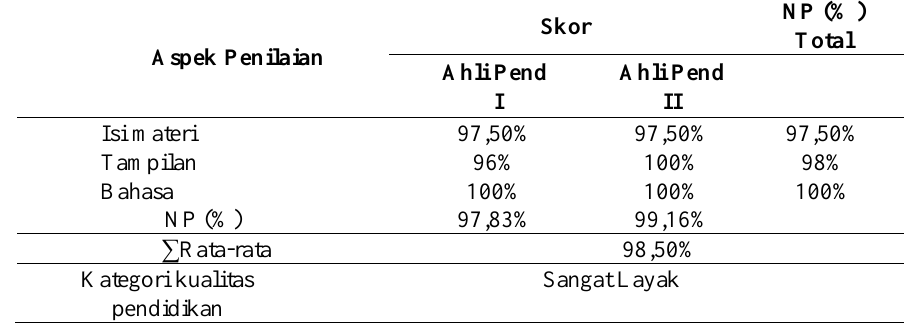
Tabel 4. Hasil Validasi Ahli